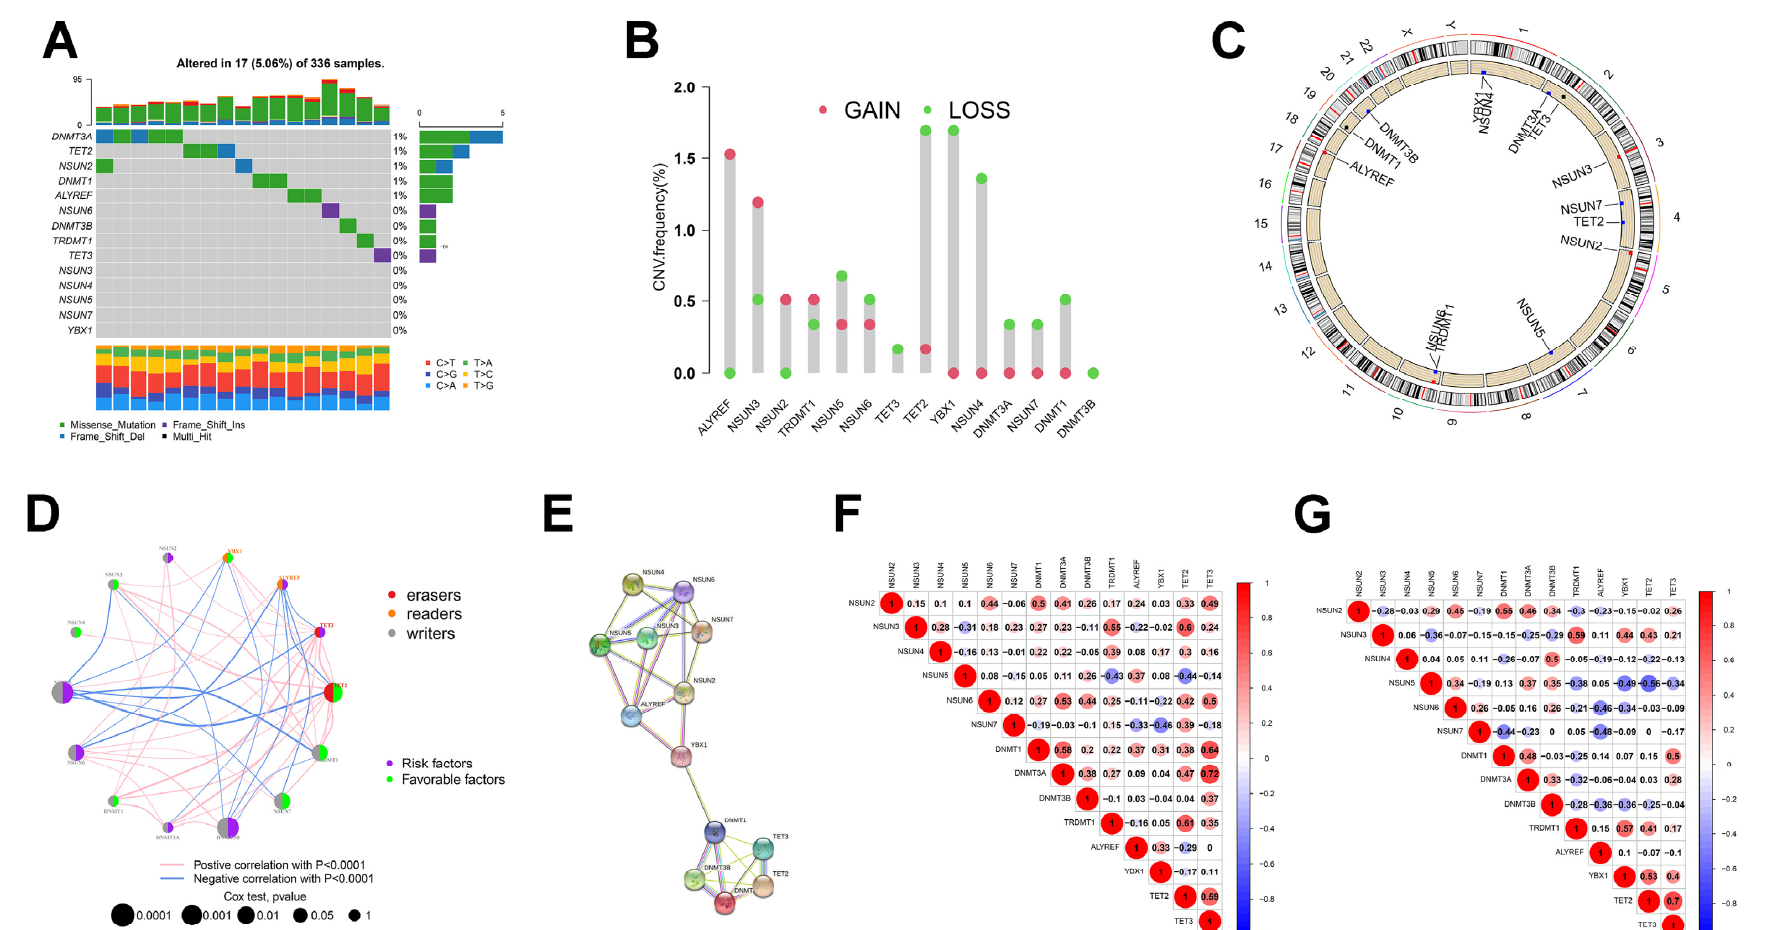
Figure 1. Landscape of genetic and expression variations of m5C regulators in ccRCC. ( A ) Mutation frequency of 14 m5C regulators in 336 ccRCC patients. ( B ) CNV variation frequency of m5C regulators in TCGA-ccRCC cohort. ( C ) Location of CNV alteration of m5C regulators on 23 chromosomes. ( D ) Interaction between m5C regulators in ccRCC. ( E ) PPI network of m5C regulators. ( F ) Spearman correlation analysis of m5C regulators in TCGA cohort. ( G ) Spearman correlation analysis of m5C regulators in ICGC